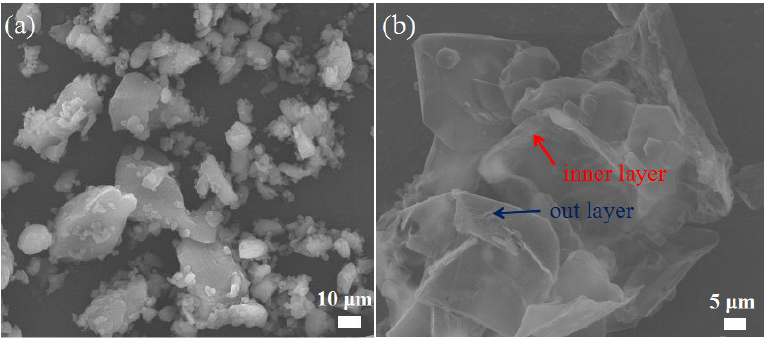
Figure 3. SEM images of the physical mixture of CL-20/HMX cocrystal and MF resin ( a ); MF resin shell after etching of the cocrystal core of CH@MF − 3 ( b ).